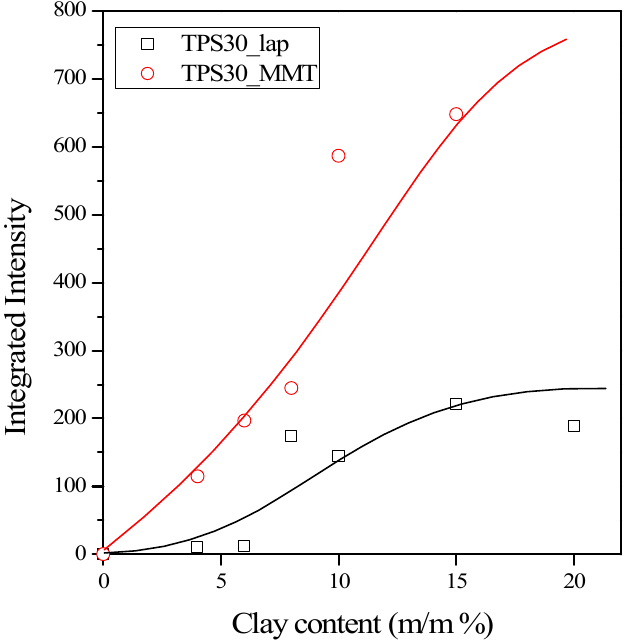
Figure 5. Integrated intensity of clay reflection plotted against the clay content.